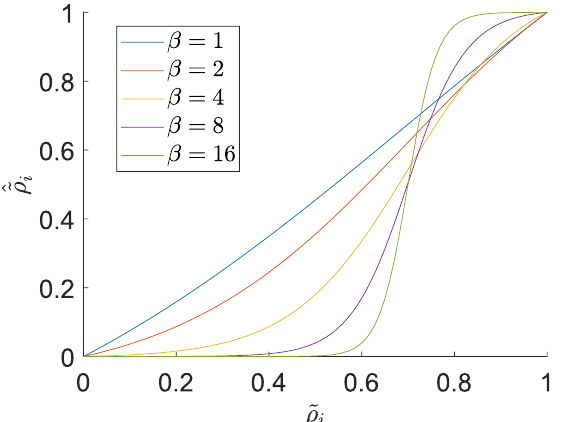
Figure 4. Threshold projection (21) for threshold η = 0.7 and different β